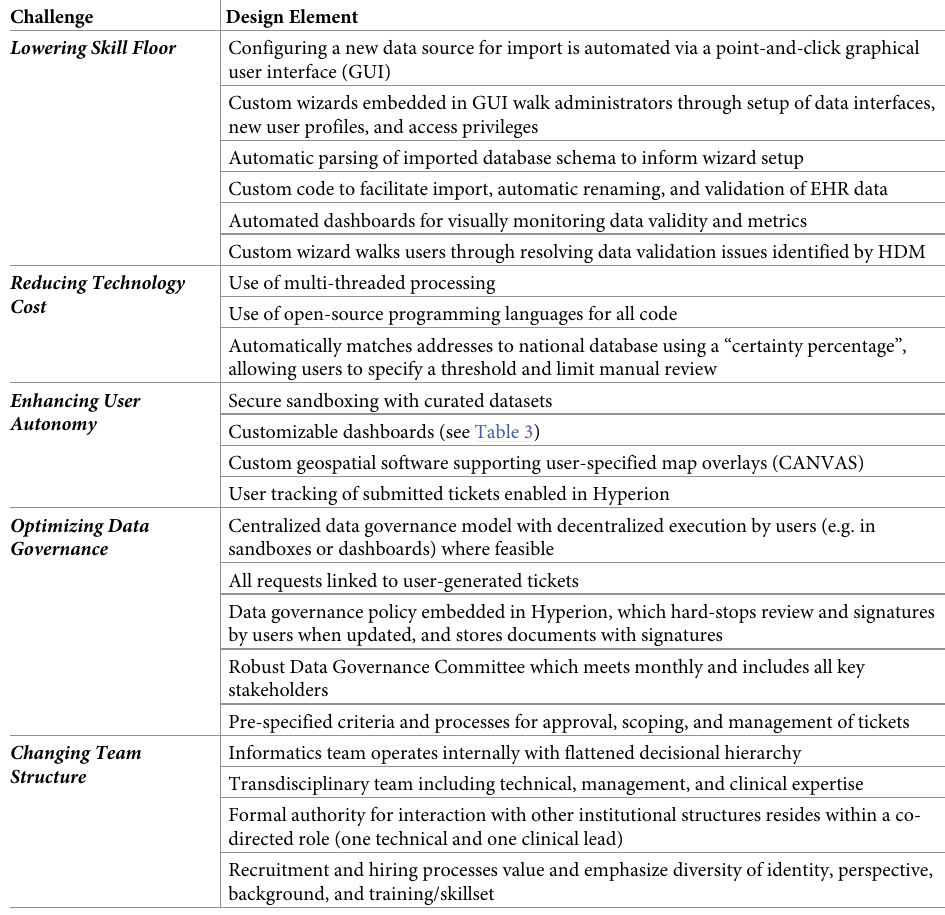
Table 2. Design elements supporting identified